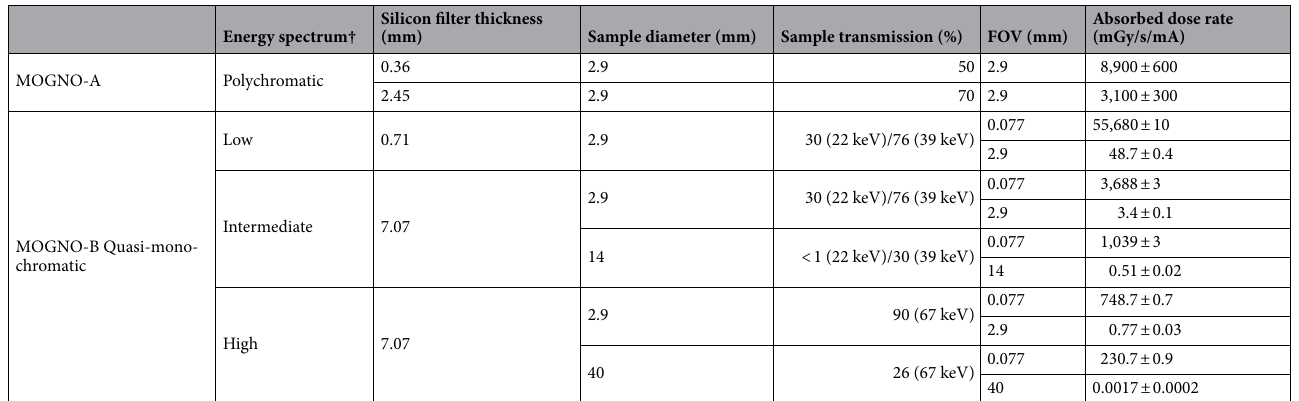
Table 4. Modeled X-ray transmission through samples of varying diameter and absorbed dose rates on a root positioned in the center of these samples in relation to X-ray beam energy spectra at MOGNO-A and MOGNO-B and different fields of view (FOVs) as shown in Fig. 3b for MOGNO-B. † Energy spectra are shown in Figs. 1a and